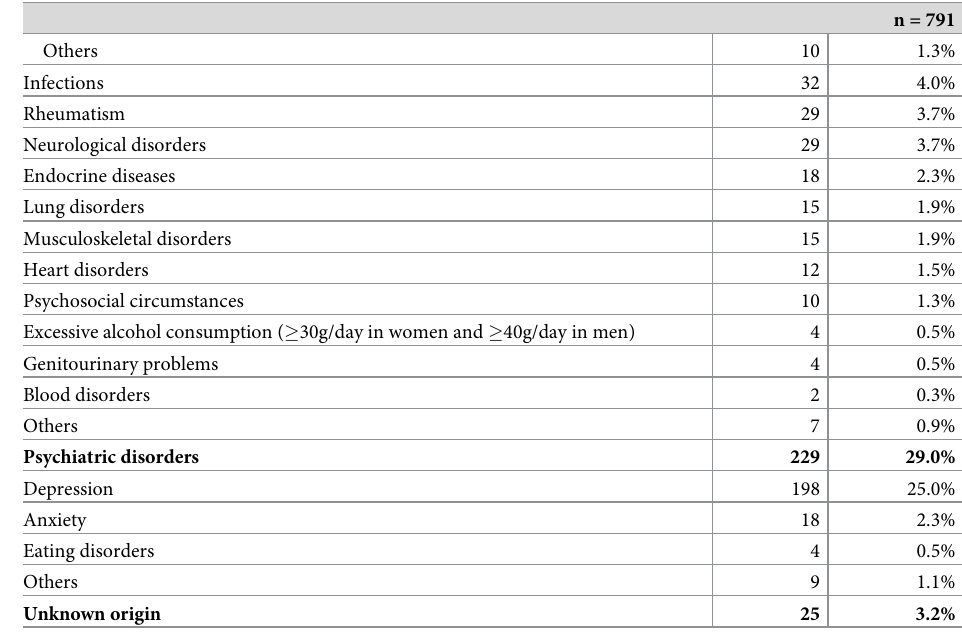
Fig 2 shows an overall mortality at 12 months of 18.6% (95%CI: 16.1–21.6). The highest rate was recorded in the neoplastic group (61.1%; 95%CI: 54.2–68.2) followed by the non- malignant organic group (6.4%; 95%CI: 4.3–9.6), psychiatric disorder (3.6%; 95%CI: 1.8–7.1) and unknown origin (3.9%; 95%CI: 0.5–25.2) (Fig 3).